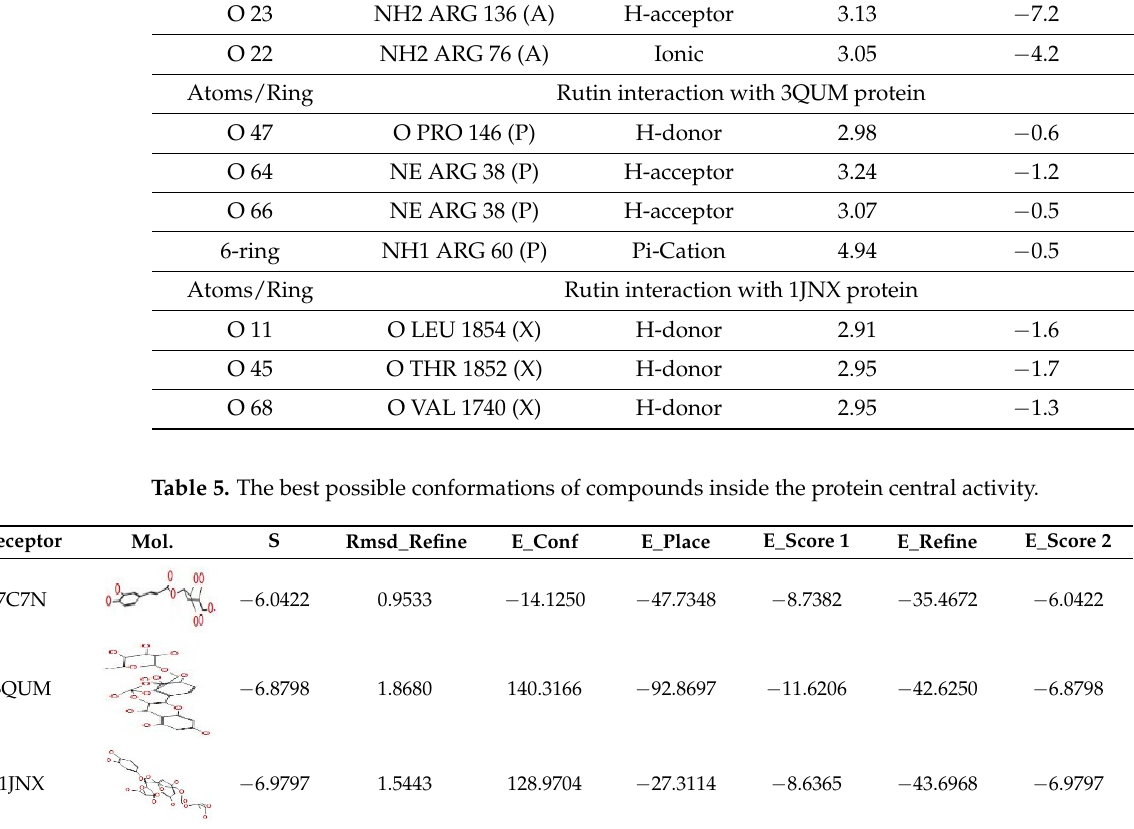
Figure 9. Docking interactions of certain compounds of latex ( a ) interaction between chlorogenic acid and active sites of 7C7N protein, ( b ) interaction between rutin and active sites of 3QUM protein, ( c ) interaction between rutin and active sites of 1JNX protein. ( d ) representative key for the types of interaction among rutin, chlorogenic acid, and proteins. Table 4. Interaction of active compounds with proteins.